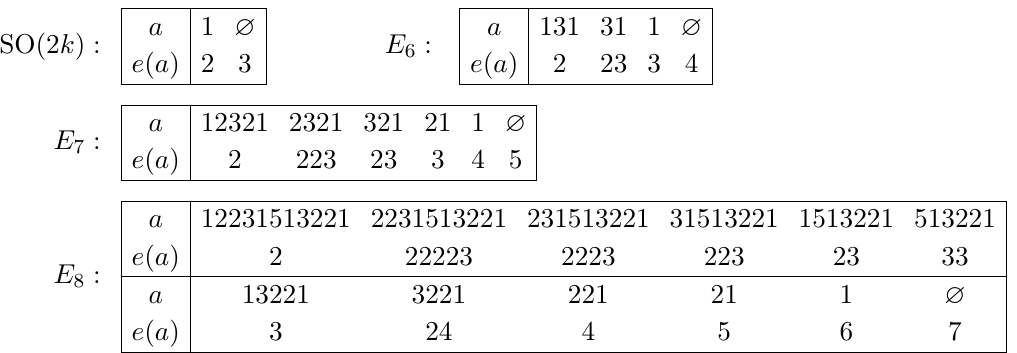
Table 1 . The map e used in the general endpoint result